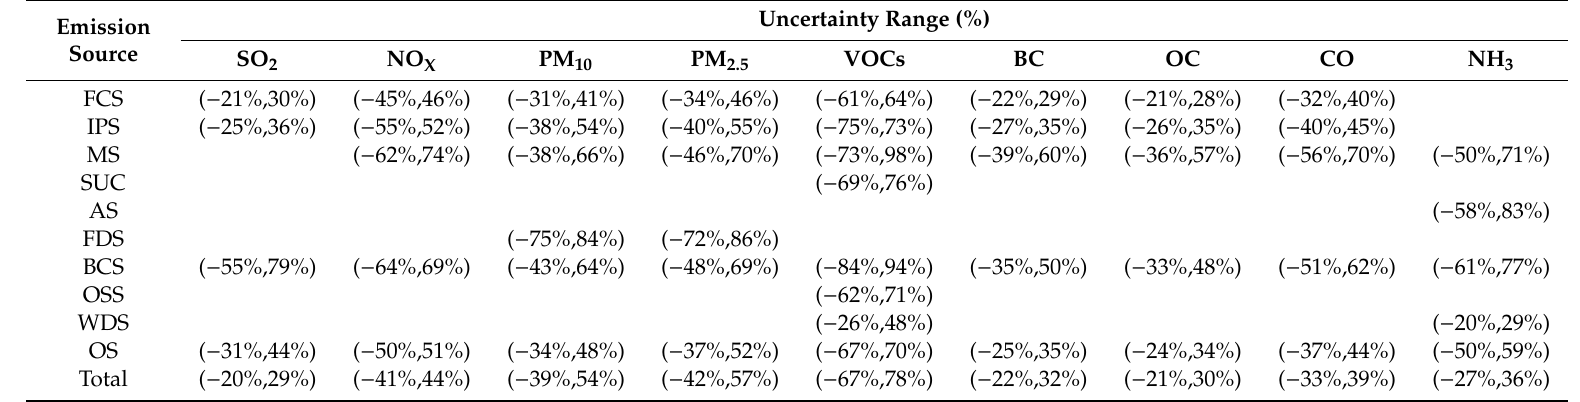
Table 1. Uncertainty of emissions from each air pollution source of Beijing,